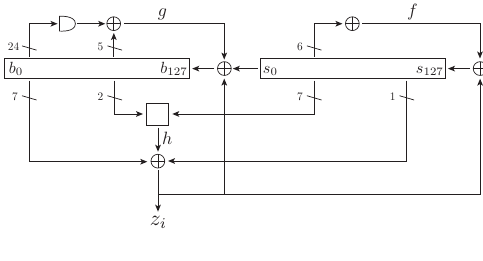
Figure 1: Structure of